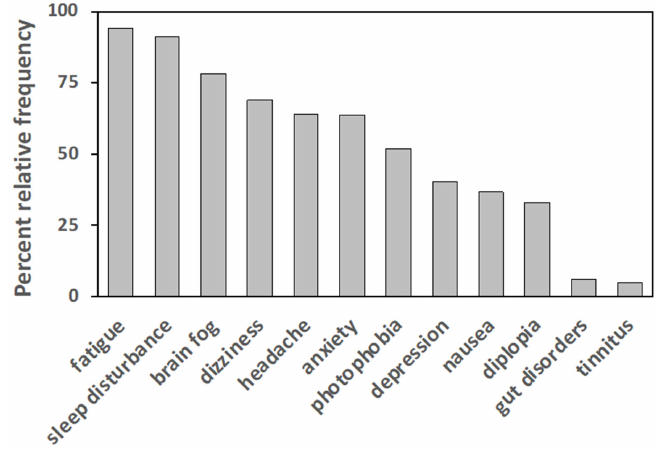
Figure 1. Percent relative frequencies of symptoms reported by participants aside from pain. For each symptom, the value represents the percentage of patients reporting that symptom (n = 352) .